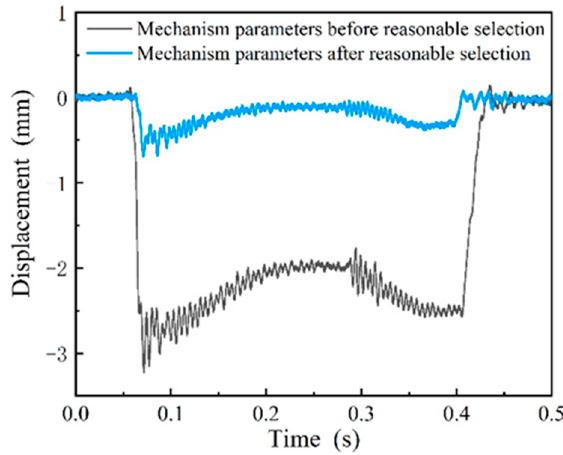
Figure 17. The motion process of the mechanism parameters before and after reasonable selection.